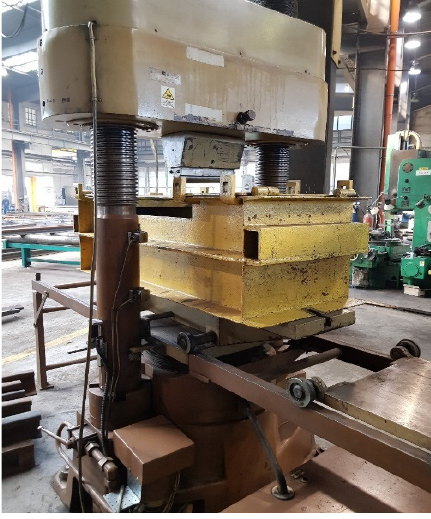
Figure 15. The press used for the test. Source: own.